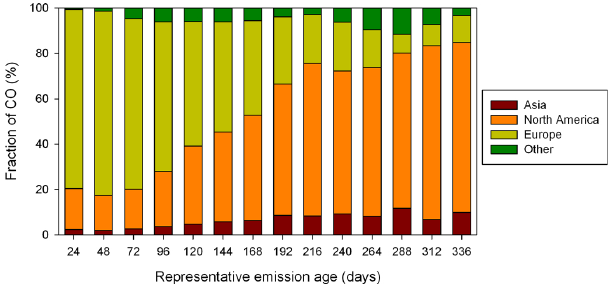
Fig. 7. Fraction of CO ant at CMN (y-axis) as a function of source regions (stacked coloured bars) and representative emission age